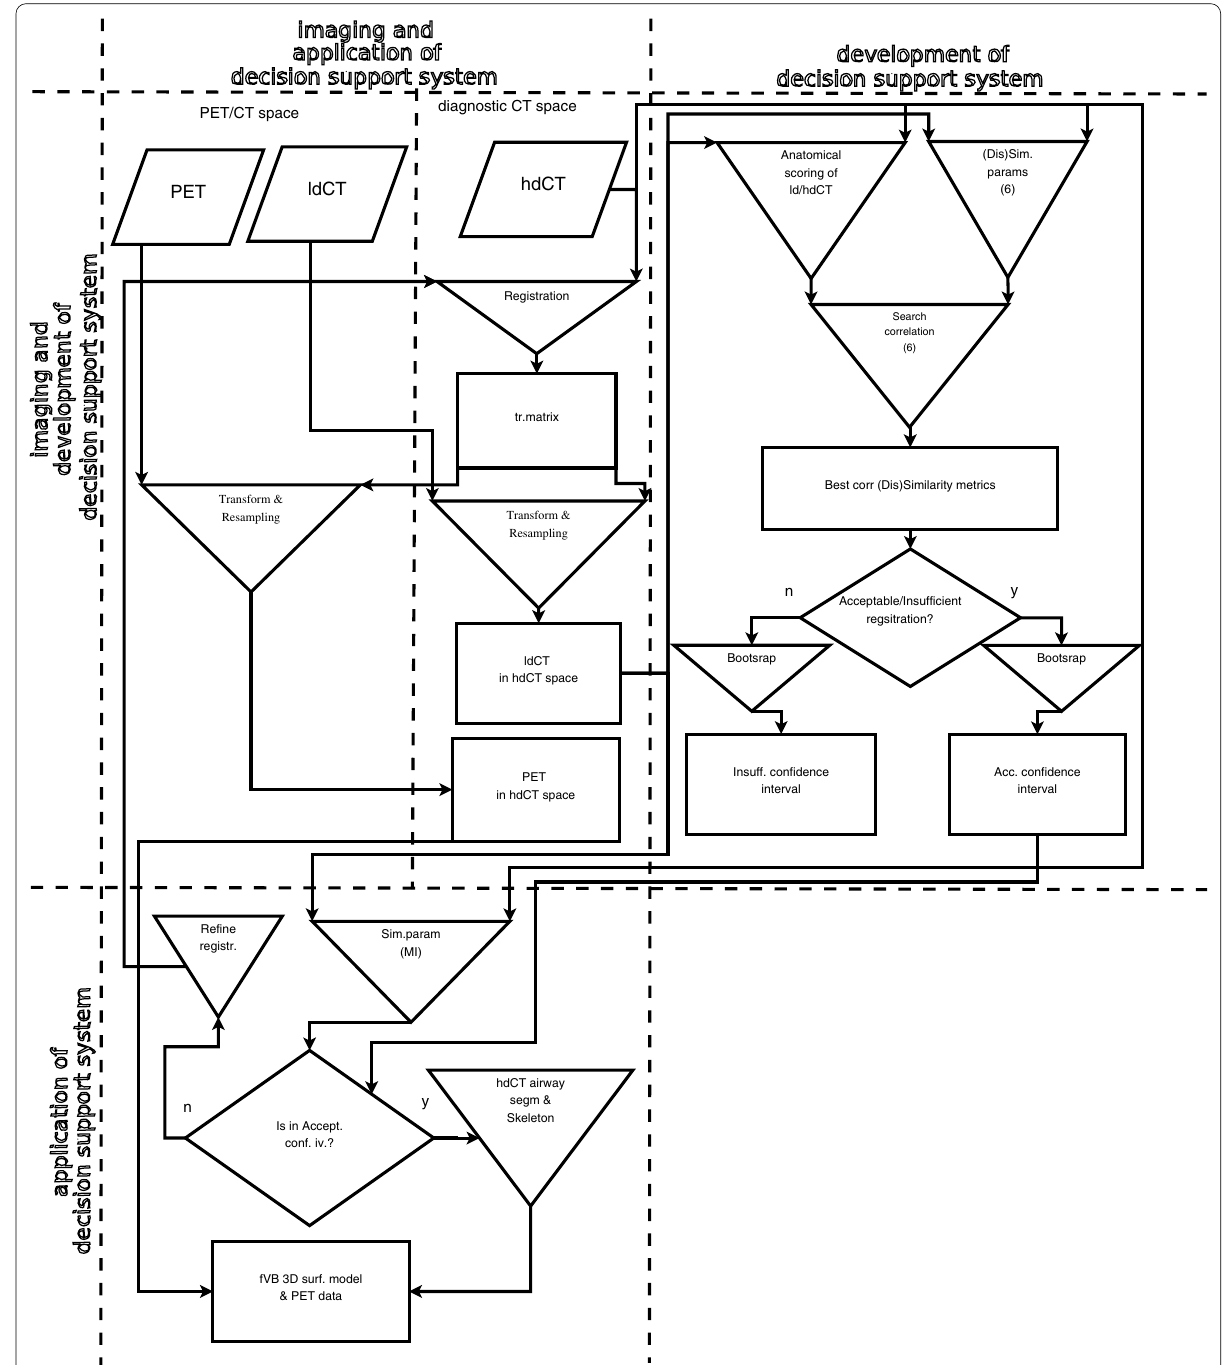
Fig. 5 Flowchart of transforming ldCT and PET into diagnostic hdCT space, calculation of intensity based (dis)similarity parameters, distance-based registration’s quality-judging metrics as well as calculation of correlation between intensity- and distance-based parameters. The flowchart also displays the steps necessary to determine the confidence intervals of MI (see detailed explanation in the